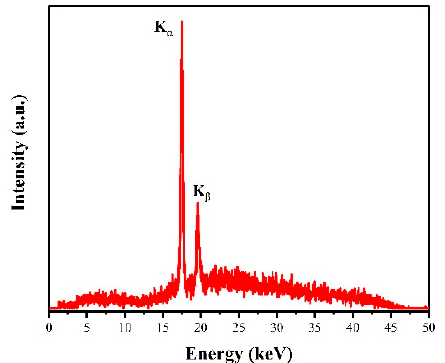
Nanomaterials 2022 , 12 , x FOR PEER REVIEW Figure 8. The X-ray spectrum of CNTs cold cathode X-ray source at V a = 50 kV. The X-ray imaging properties of the X-ray source were also studied. The X-ray focal spot was measured following the European standard (EN 12543-5), where the resolution is obtained based on the line profiles of the transmitted X-ray intensity of a 1 mm diameter tungsten wire phantom in two orthogonal directions [20]. To satisfy the conditions set by this standard, the wire and flat panel X-ray detector were placed, respectively, 15 and 20 cm apart from the X-ray source, horizontally. The X-ray projection image of the tungsten wire phantom is shown in Figure 9a. The horizontal and vertical size of the X-ray focal spot was calculated to be about 473 μ m and 521 μ m from the line intensity profiles of the cross wires shown in Figure 9b. The focal spot demagnification factor is approximately 3.2, which is calculated from the ratio of the cathode size (160 μ m) and the true focal spot diameter. X-ray imaging results of a line pair card was presented in Figure 9d and up to 3.55 line pairs/mm was clearly resolved, indicating that the imaging resolution of CNT cold cathode X-ray source can reach to approximately 140 μ m. The integrated circuit chips were also clearly imaged as shown in Figure 9d. Figure 9. ( a ) X-ray projection images of vertically crossed tungsten wires. ( b ) Intensity profiles along the vertical and horizontal directions. X-ray images of line pair card ( c ) and integrated circuit chips ( d ).